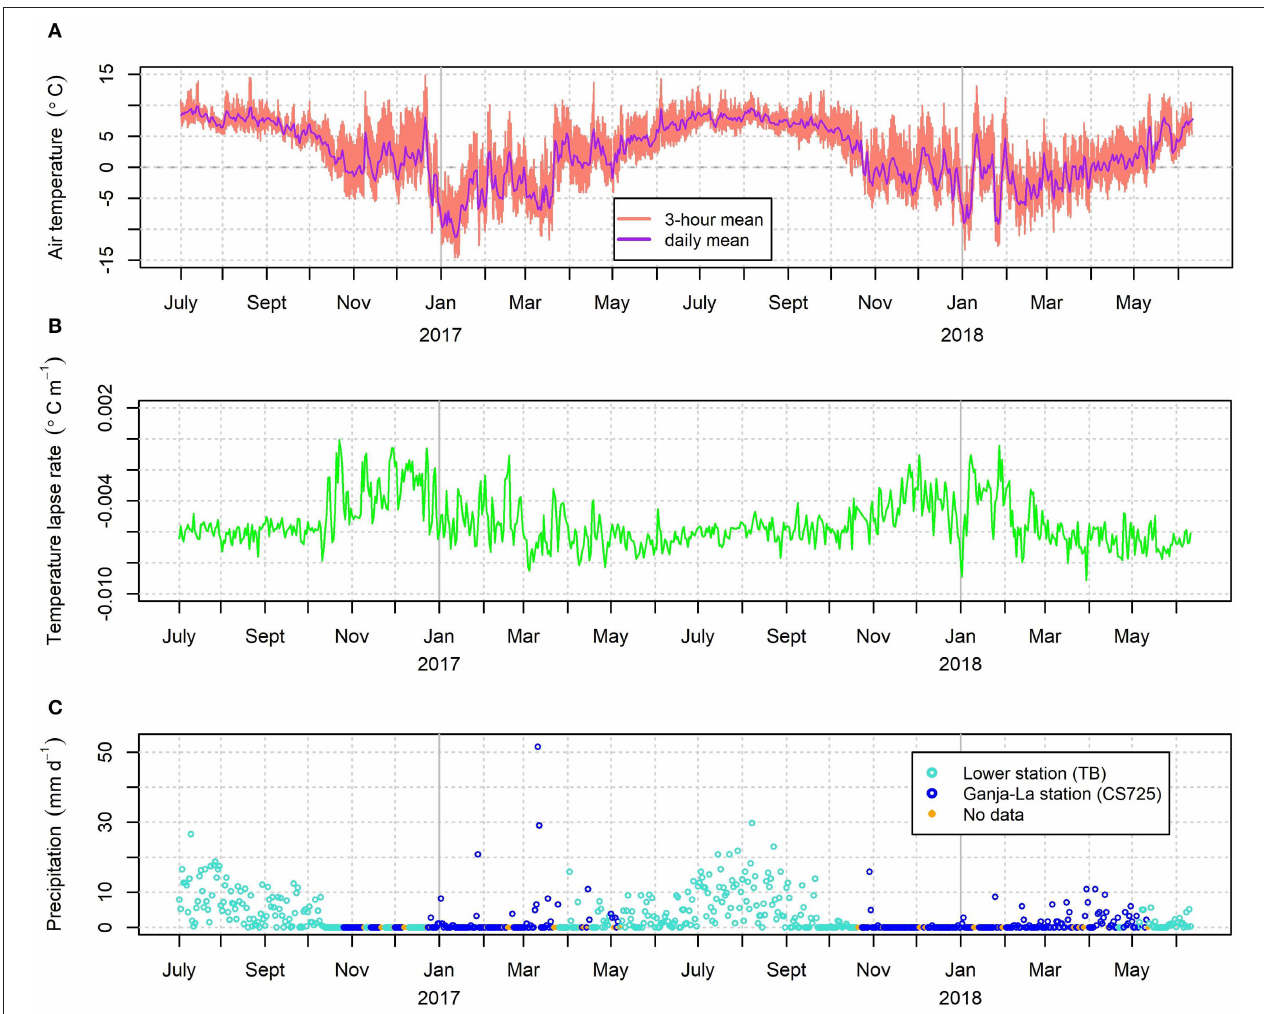
FIGURE 2 | Model input forcing time series for the Lower station (4,200m a.s.l.) from July 2016 to June 2018. (A) The daily and 3-hourly mean air temperature; (B) the daily mean temperature lapse rate, based on the air temperature difference between the Lower and Ganja La stations; (C) the daily precipitation data based on the Lower (tipping bucket, TB) and Ganja La (SWE-sensor, CS725) stations, respectively. The 4% of missing precipitation data (for which zero precipitation is assumed) is indicated by orange circles.